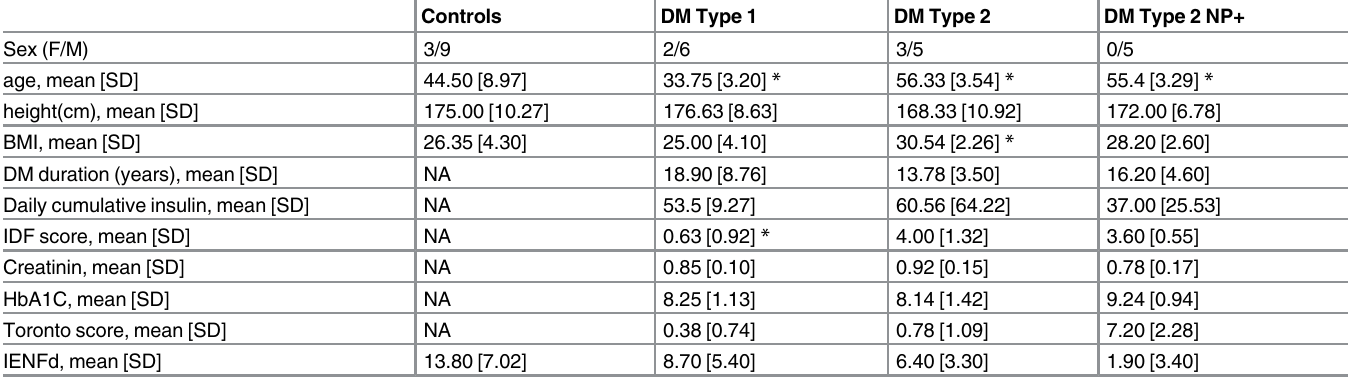
Table 1. Baseline demographics.